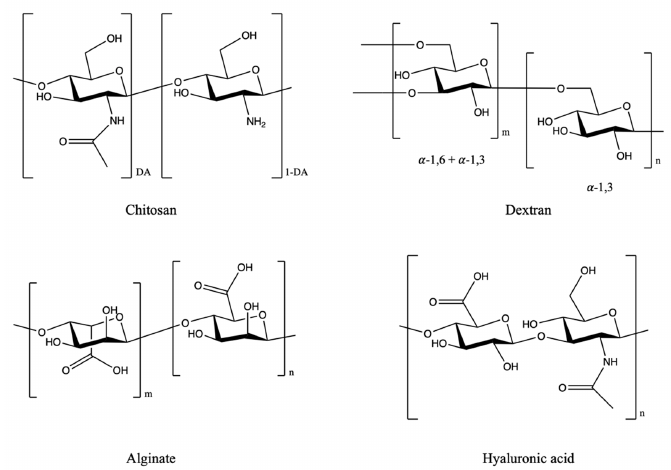
Figure 1. Chemical structures of polysaccharides used as drug carriers (DA: degree of deacetylation; m,n: no. of units). m,n: no. of